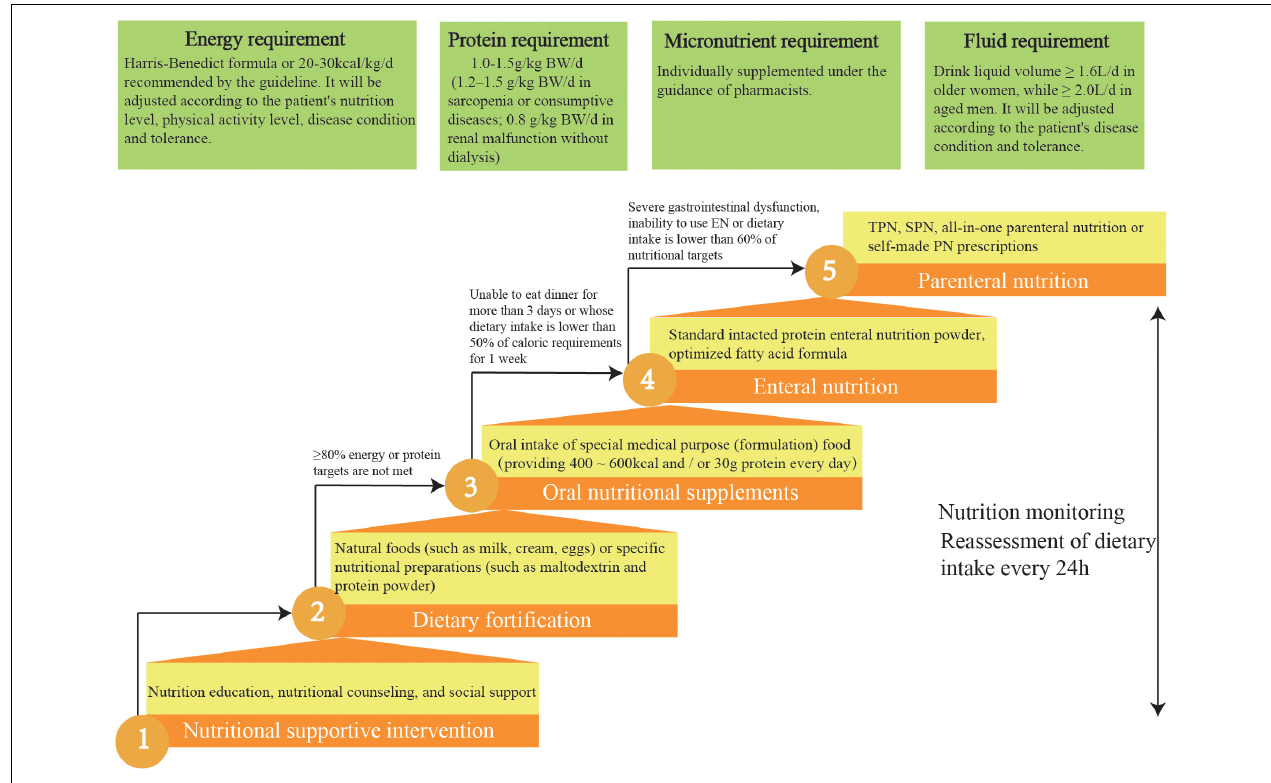
FIGURE 3 | Five-steps-ladder nutritional approach used for the intervention group patients. TPN, total parenteral nutrition; SPN, supplementary parenteral